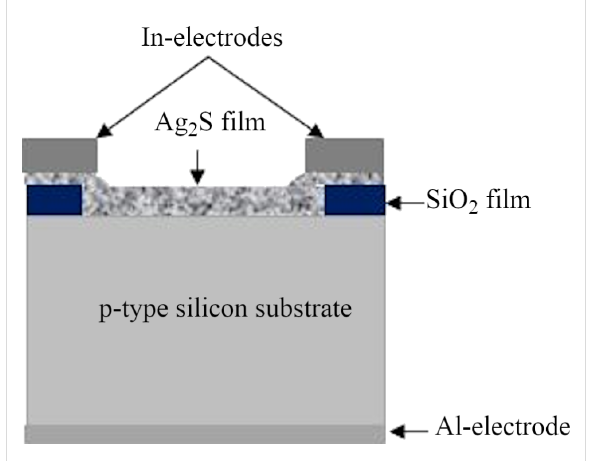
Figure 2: Cross-sectional view of the n-Ag 2 S/p-Si heterojunction photodetector.